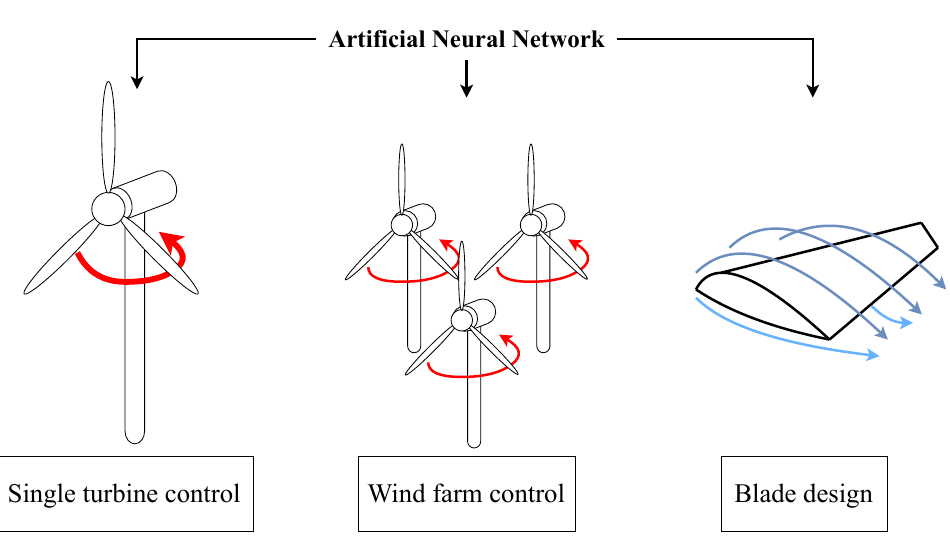
Figure 1. Schematic of our